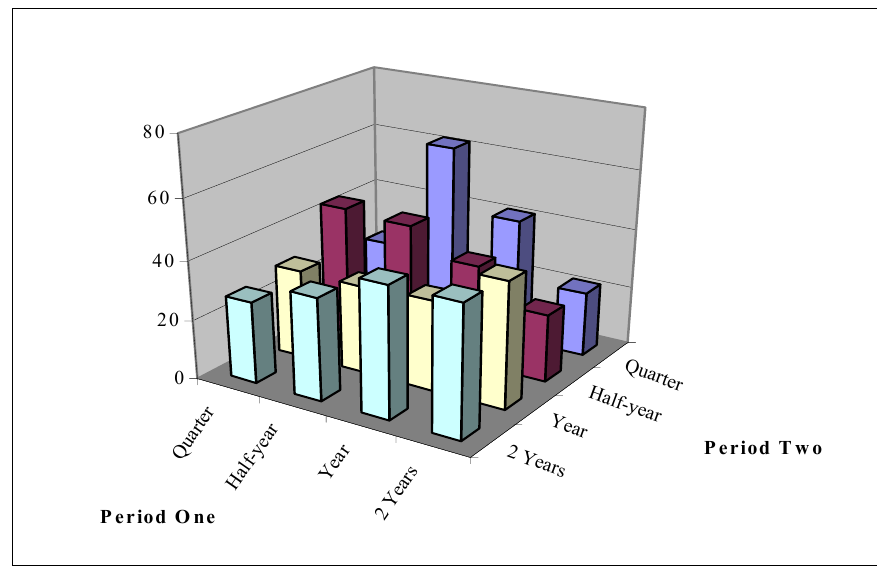
Figure 1: Equity risk-adjusted chi-squared